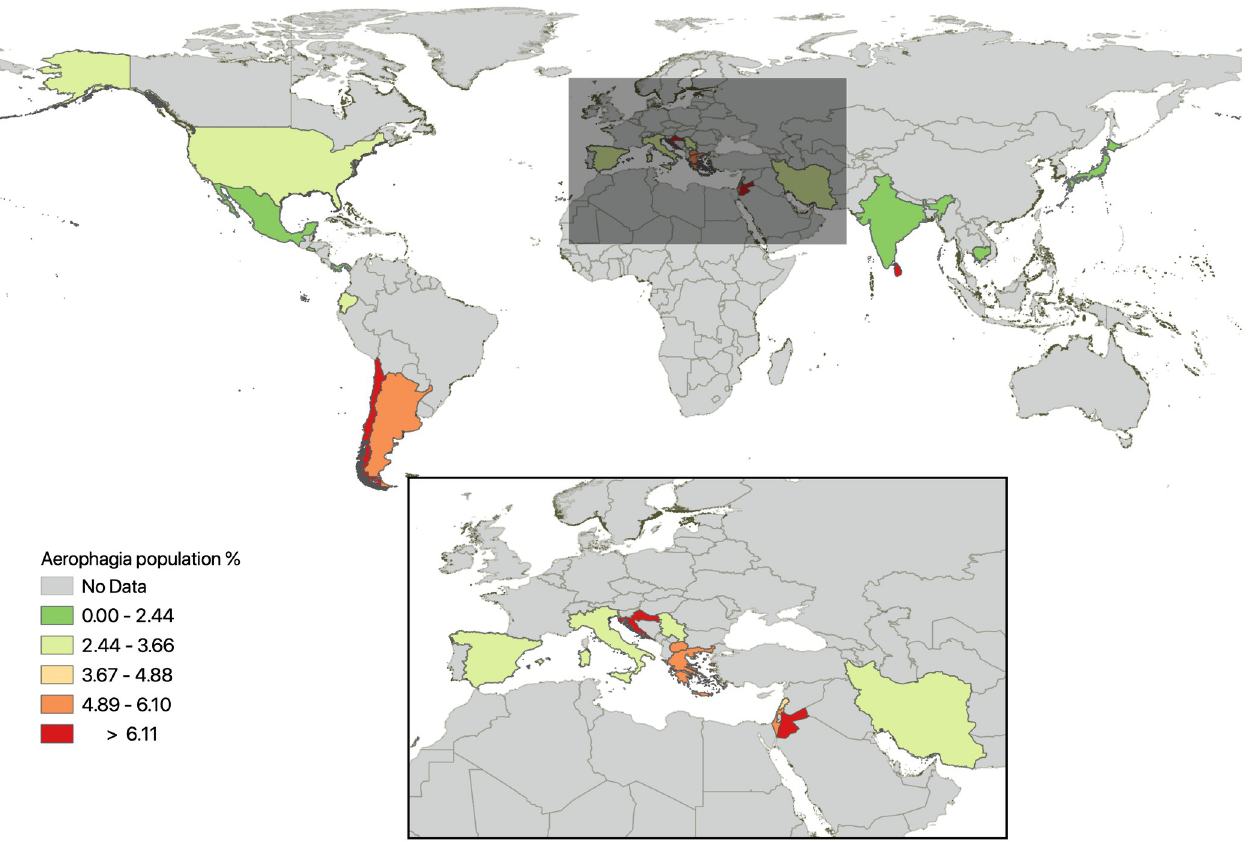
Fig 3. Prevalence of aerophagia: The world map. Final map was created using ArcGIS software by ESRI, using Basemaps supported by Esri under a license, original Copyright 2019 ESRI. All rights reserved.